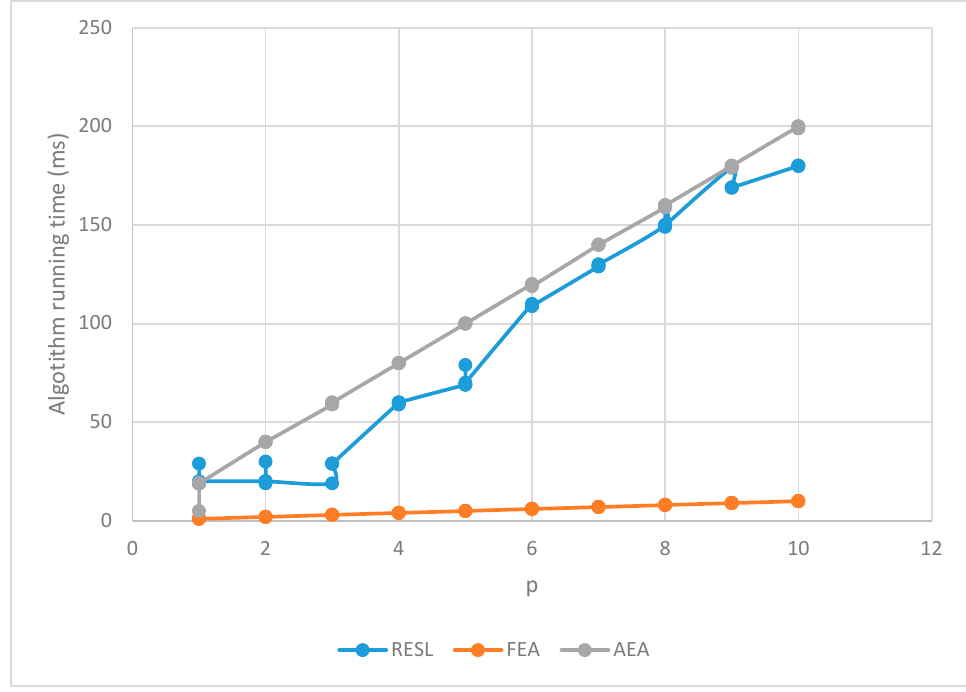
Figure 3. Algorithm running time.